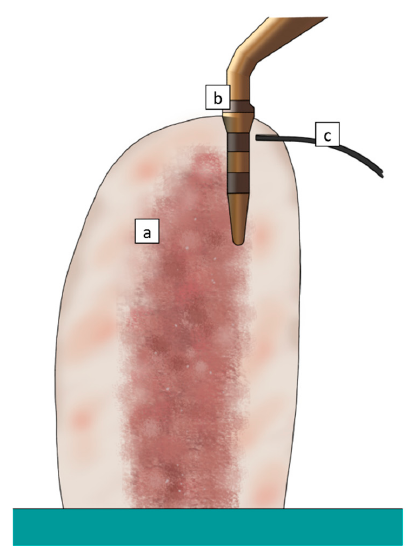
Figure 2. Schematic section of the bone sample ( a ) with the ultrasonic tip ( b ) and the thermometer probe ( c ) at completion of osteotomy.